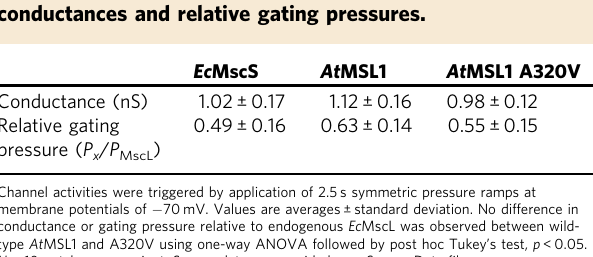
Table 3 Ec MscS and At MSL1 and A320V have similar conductances and relative gating pressures.